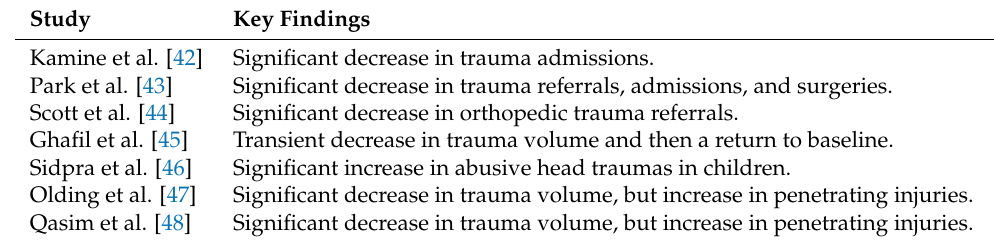
Table A1. Studies evaluating trauma during COVID-19 pandemic. Study Key Findings Kamine et al.